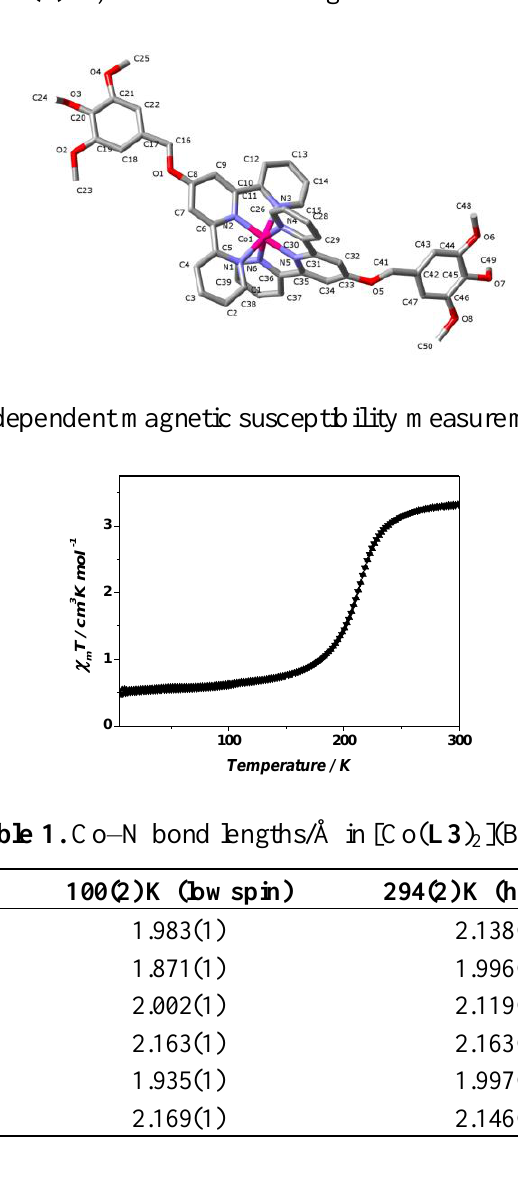
of [Co( L3 ) ](BF ) at 100(2) K, with atom labelling shown as used in the text. 2 4 2